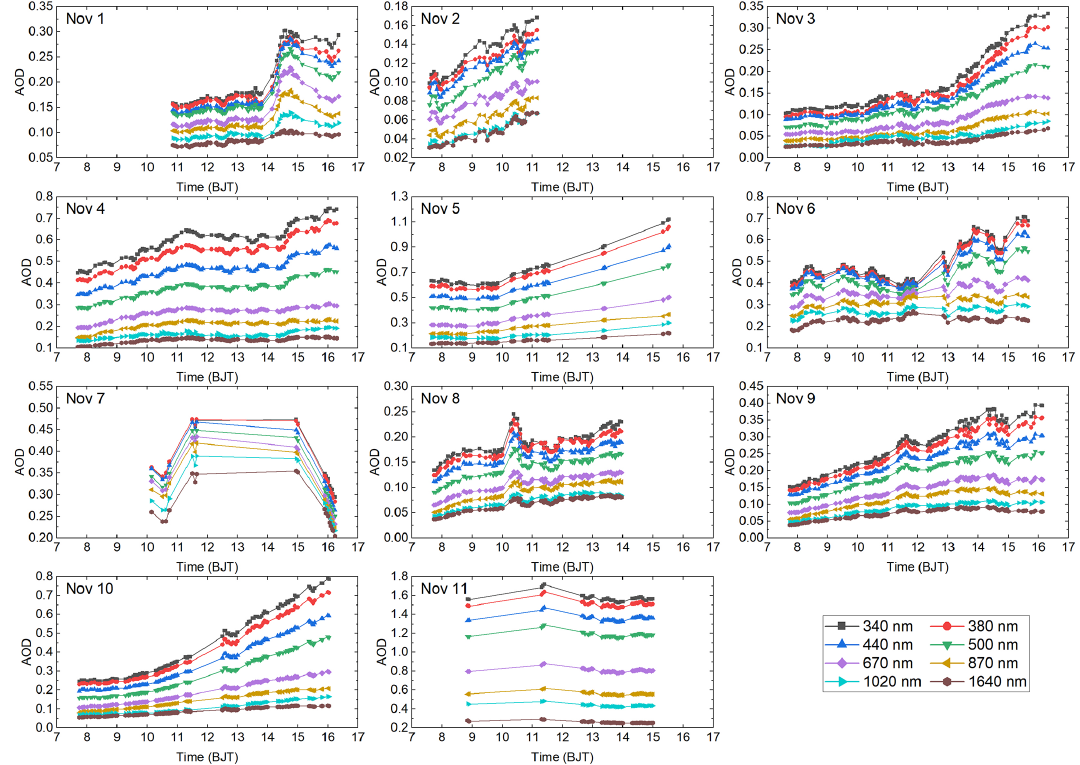
Figure 6. Diurnal variation of the AOD at each wavelength on 11 case